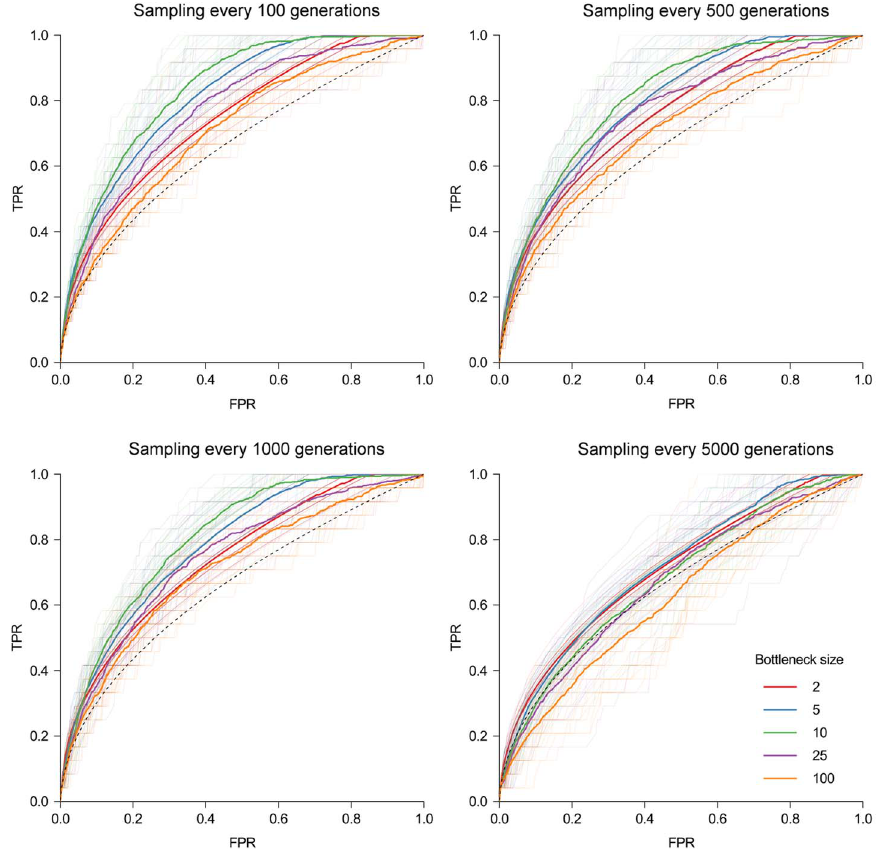
Figure 3. ROC curves for estimated networks under various scenarios. Under each scenario, 25 datasets were simulated. Lighter lines indicate the ROC curve for a particular replication, while the heavier lines indicate the mean ROC curve for a given scenario. The dashed line indicates the ‘no information’ ROC curve, where sources are guessed at random. It was assumed that the order of infection is known, such that individual k has k { 1 potential sources (meaning that guessing sources at random produces an ROC curve above the diagonal). TPR: true positive rate; FPR: false positive rate.